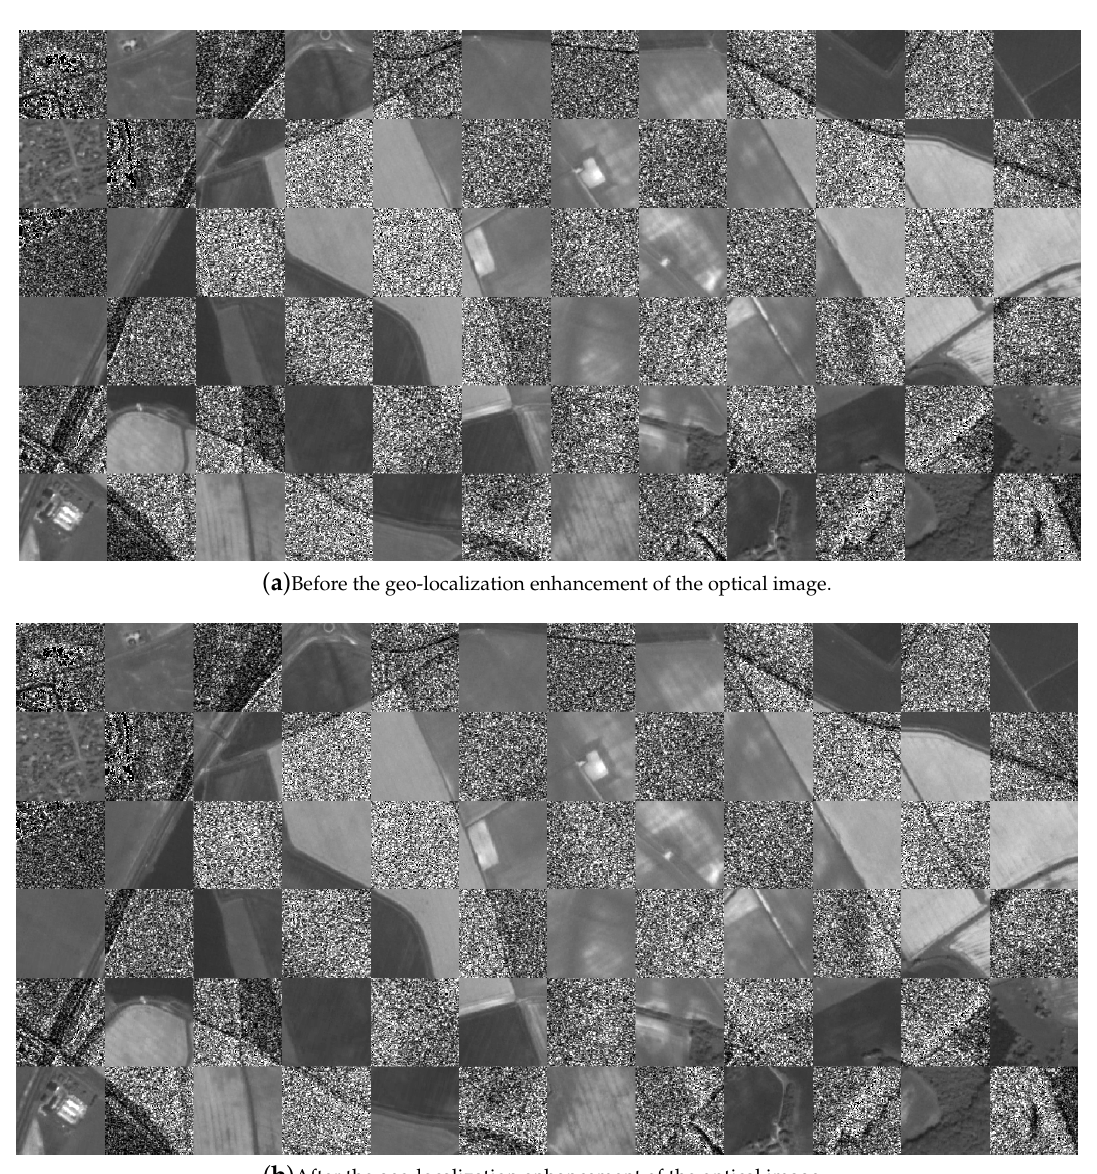
Figure 7. Checkerboard overlays of two optical and one SAR image with a pixel spacing of 2.5m and image tiles size of 100 100m: ( a ) shows the optical image before and ( b ) after the sensor model × adjustment (geo-localization enhancement) through the generated matching